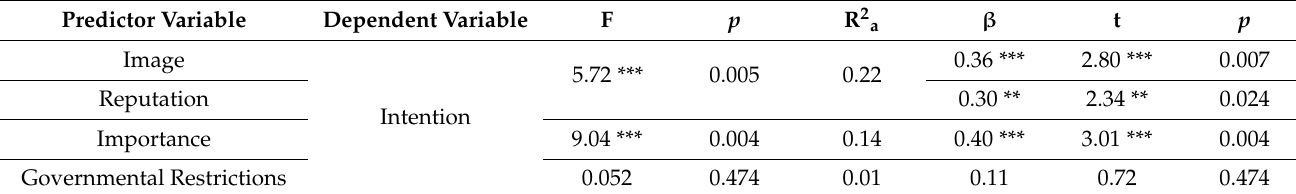
Table 5. Linear Regressions of H3 (Source—IBM SPSS Statistics